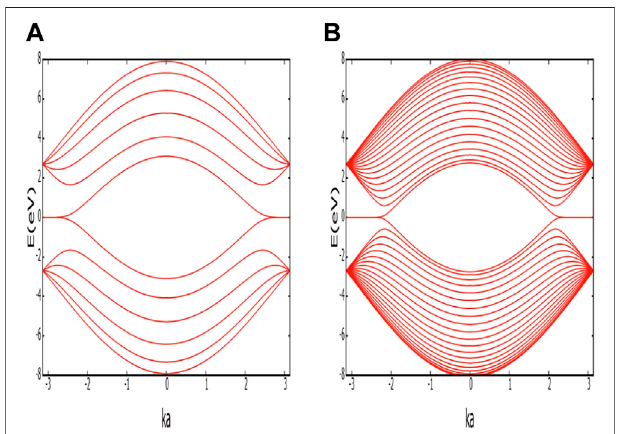
FIGURE 4 | ZGNR band structure (A) for small N and (B) for large